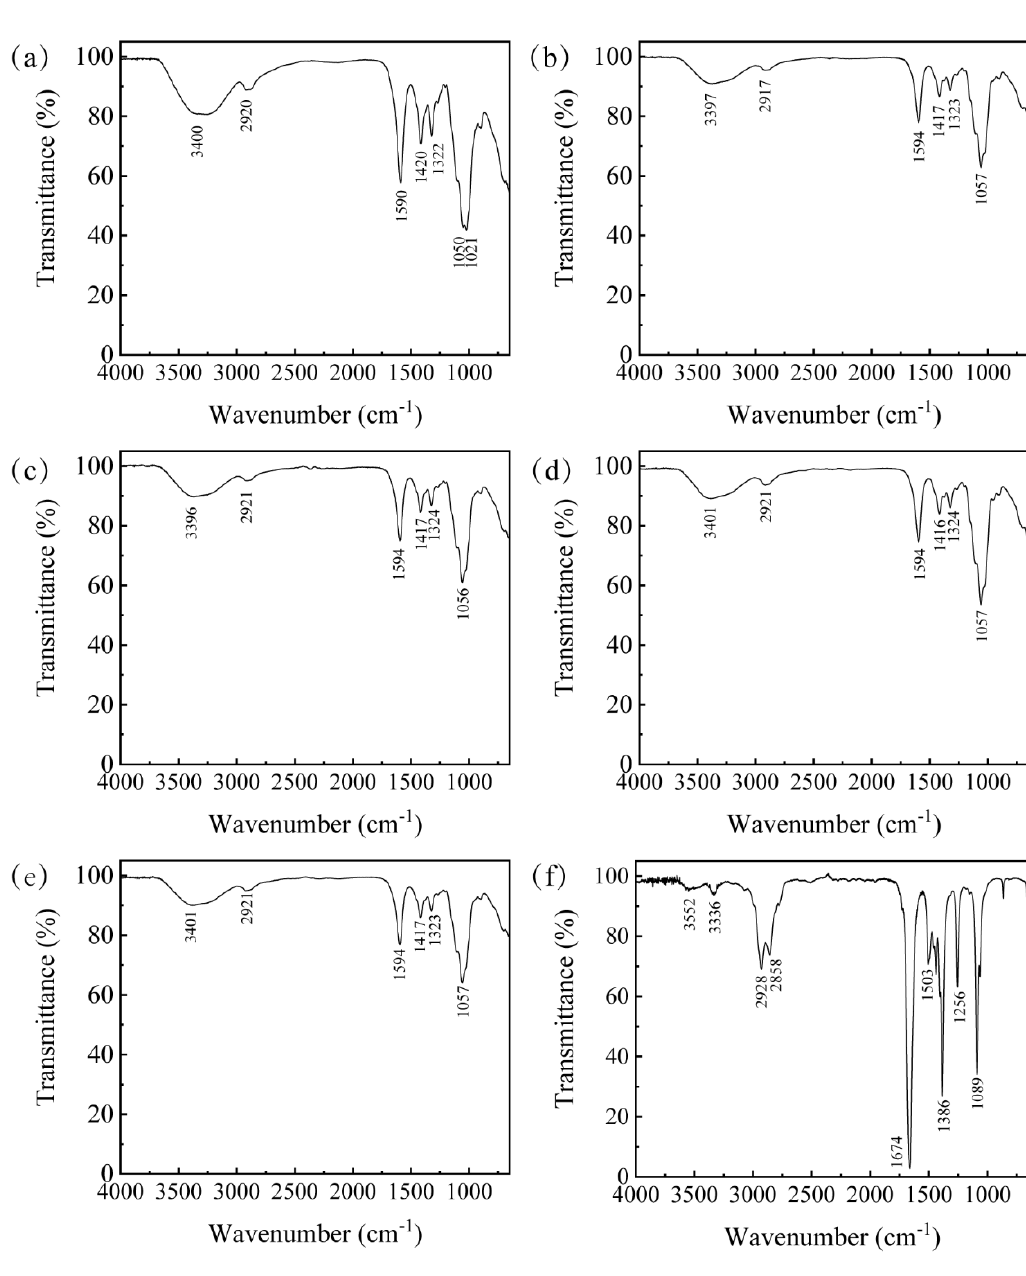
Figure A1. FTIR spectra: ( a ) CPM-0; ( b ) CPM-3; ( c ) CPM-5; ( d ) CPM-7; ( e ) CPM-10; ( f ) DMF. The characteristic absorption peak of CPM-0 (Figure A1a) is observed at 3400, 2920, 1590, and 1420 cm −1 , which correspond to the stretching vibration of O-H, C-H(aliphatic), COO − (asymmetric), and COO − (symmetric), respectively. The characteristic absorption peak of MC was observed at 3000 – 2800, 1646, 1458, and 1300 – 1100 cm −1 , which correspond to the stretching vibration of C-H, C – C ring stretching, C-H, and C-O. The characteristic absorption peaks of MC roughly overlapped with those of CMC, so the FTIR of CPM-3, CPM-5, CPM-7, and CPM-10 (Figure A1b – e) was similar to that of CPM-0 (Figure A1a). Besides, there was no characteristic absorption peak of DMF (Figure A1f, 3552, 3336, 1674, 1386), which indicated that there was no residual of the pore-forming agent DMF.